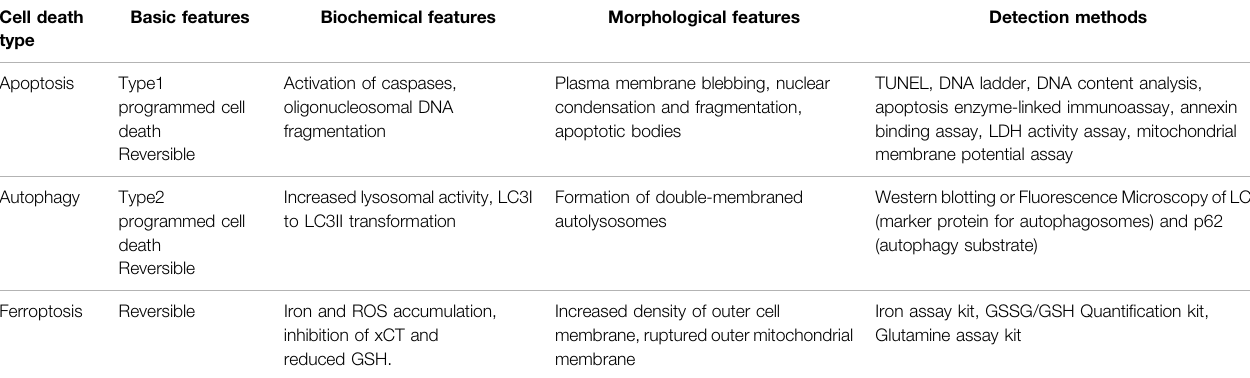
TABLE 4 | Diverse types of cell death in